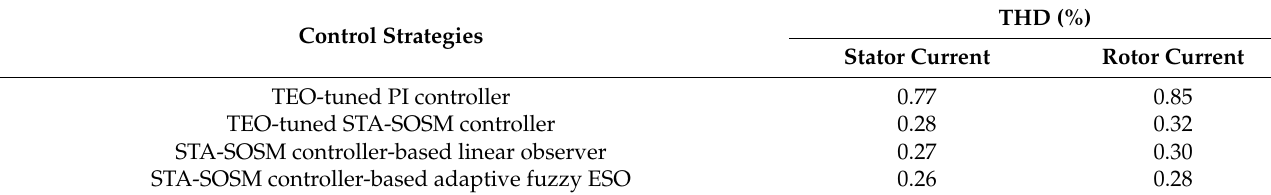
Table 4. Comparison of stator and rotor currents’